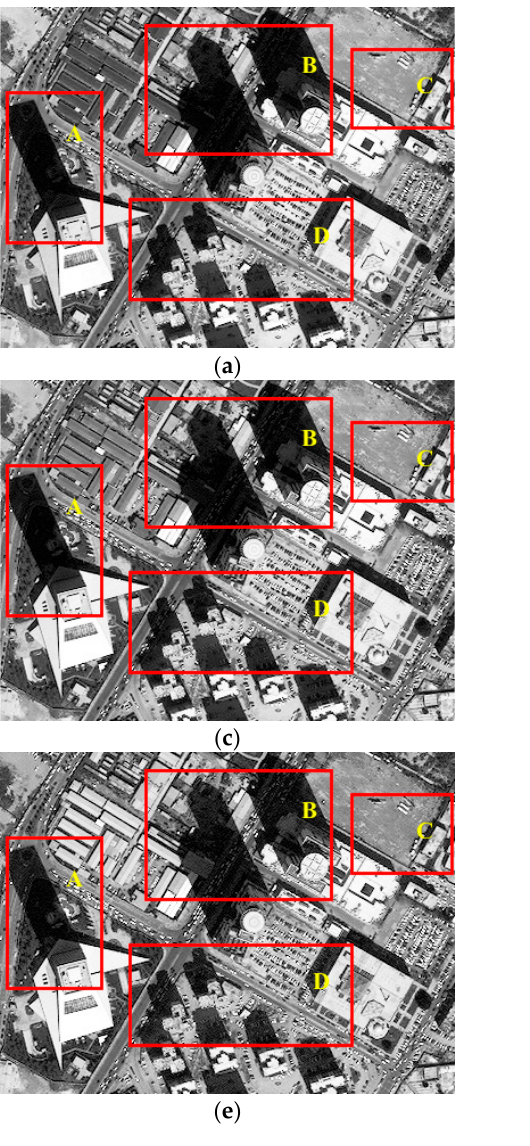
Figure 4. Resulting images of the test image Tripoli-1 compensated before and after by the IRB shadow compensation algorithm in terms of red (R), green (G), and blue (B) components. ( a ) R before shadow compensation. ( b ) R after shadow compensation. ( c ) B before shadow compensation. ( d ) B after shadow compensation. ( e ) G before shadow compensation. ( f ) G after shadow compensation.